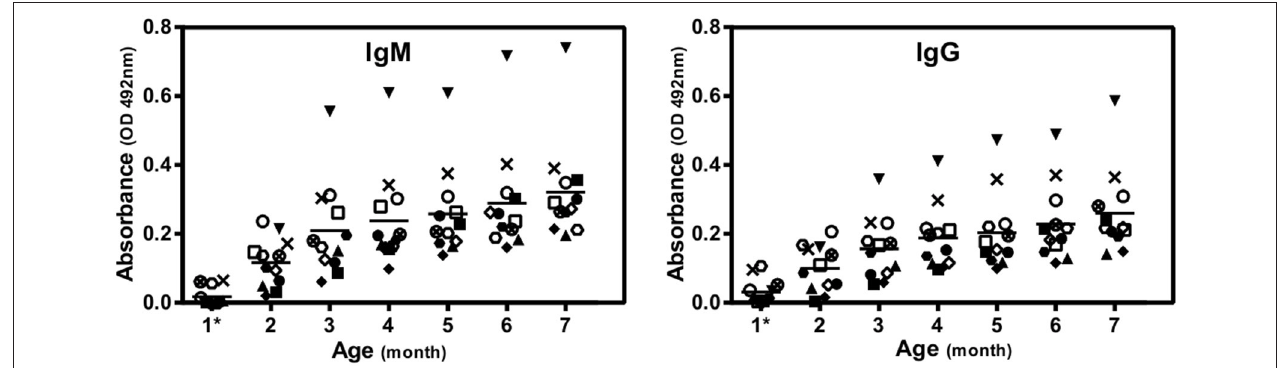
FIGURE 1 | The levels of anti- α Gal antibodies are variable between genetically identical GalT-KO mice. IgM and IgG were determined by ELISA and expressed in absorbance units (OD 492nm). Each mark corresponds to a different mouse and represents the arithmetic mean of three replicates. The short horizontal line represents the arithmetic mean resulting from these determinations ( n = 11). *3 weeks of age.